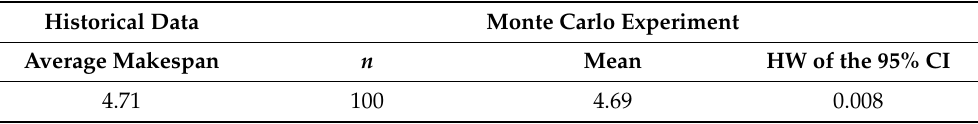
Figure 7. Average makespan distribution of the 100 simulation replicates from the performed Monte Carlo experiment in AnyLogic (The red vertical line is at the mean of the average makespan of the simulation replicates, and the black polyline is the cumulative distribution function). Table 3. Comparison of the actual and simulated average makespan of the baseline schedules (in hours) for three